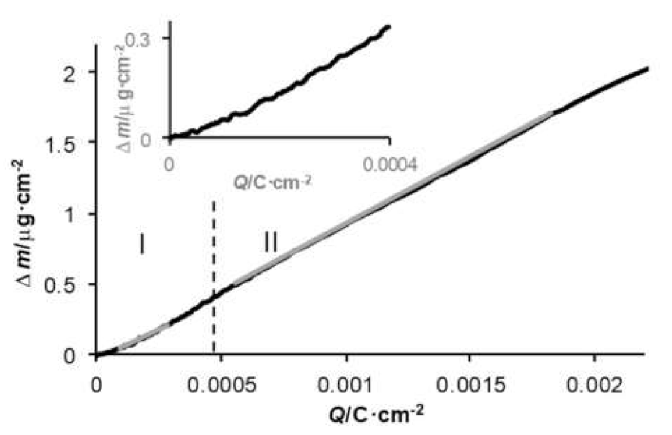
Figure 6. Plots ∆ m vs. Q for anodic process for of poly [Ni(salcn)] (1 electropolymerization cycle) in TBAClO 4 /CH 2 Cl 2 , Pt/quarzglas, v = 0.05 V · s − 1 , after reduction 40 s at 0 V, vs. Ag/AgCl; grey parts of the curve—trend lines for the ∆ m = f( Q )